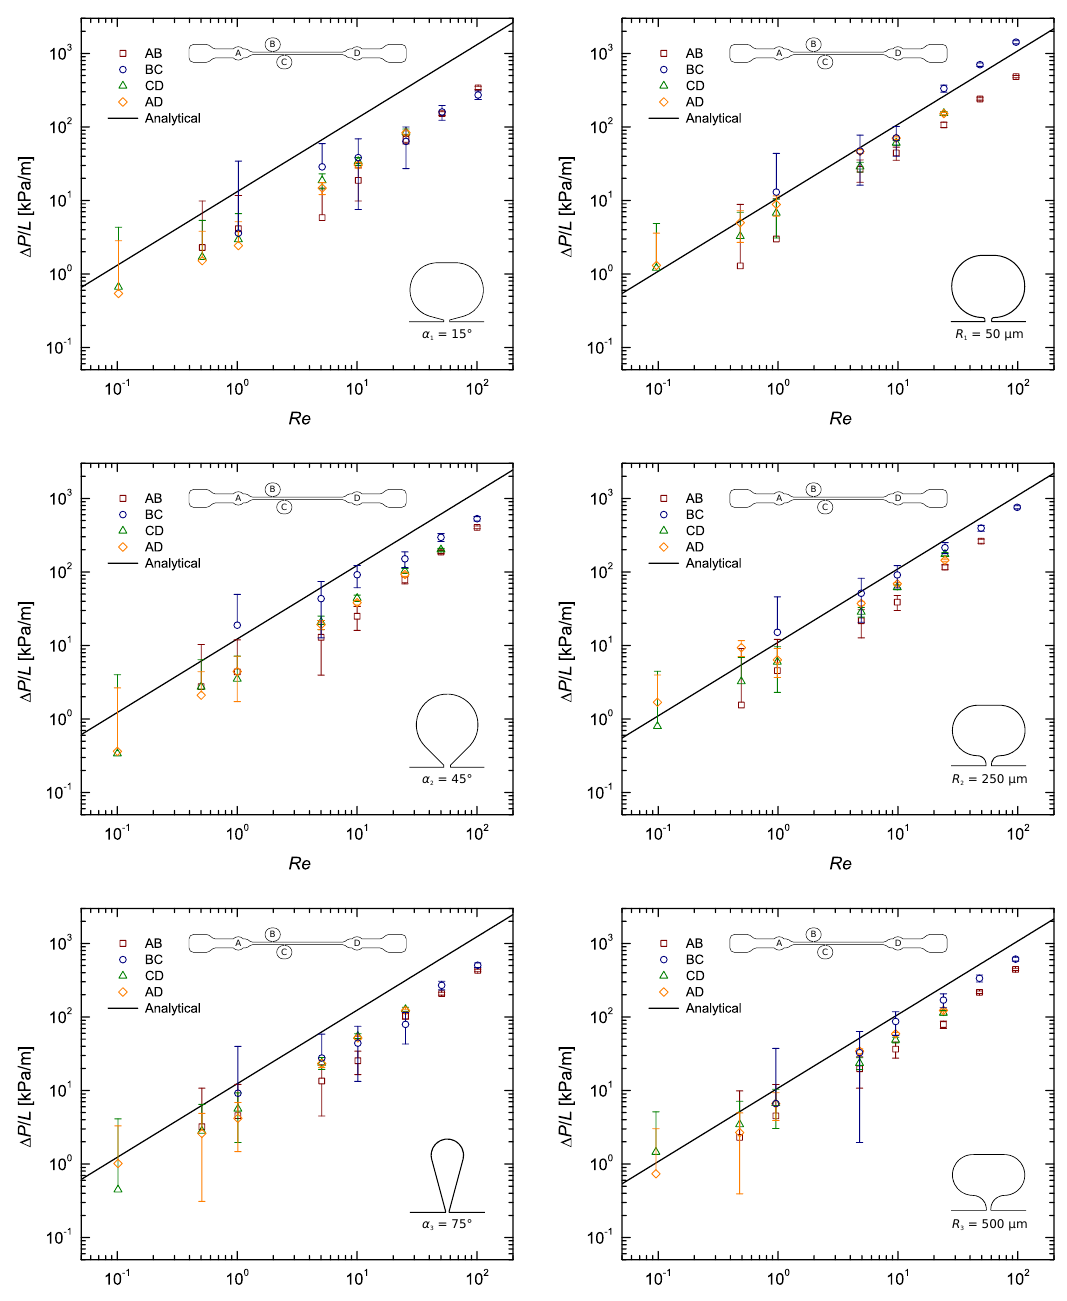
Figure A4. Pressure gradient as a function of the Reynolds number for the flow of DI water along a rectangular microchannel: Pressure taps with sub-channel width w 3 = 162 µ m; α taps on the left and R taps on the